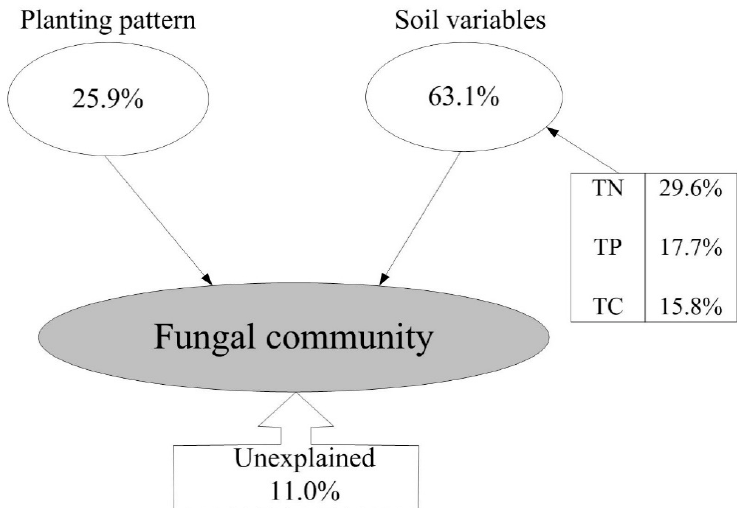
Figure 7. Variance partitioning analysis (VPA) showing the effects of planting pattern and soil variables on the phylogenetic structure of fungal communities based on MiSeq sequencing were calculated from relative OTU abundances and soil chemical properties. The planting pattern explained 25.9% of the variation of the fungal community structure, and soil environmental factors explained 63.1% of the variation. The TN, TP, and TC explained 29.6%, 17.7%, and 15.8% of the variation, respectively.